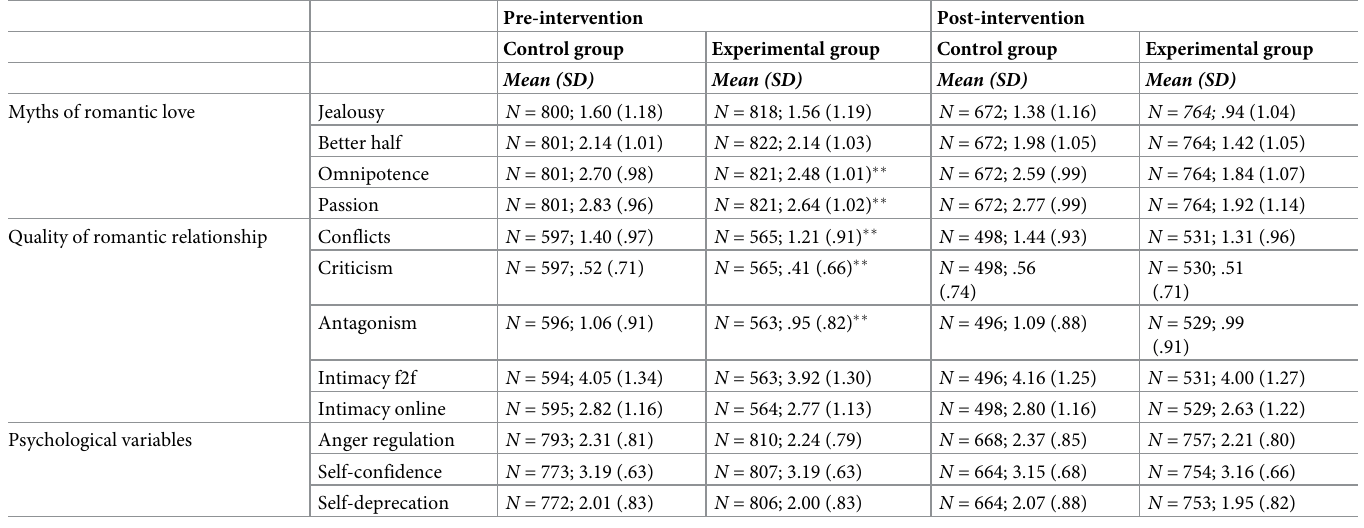
Table 6. Results of myths of love, quality of relationship, anger management and self-esteem for control group and experimental group in both